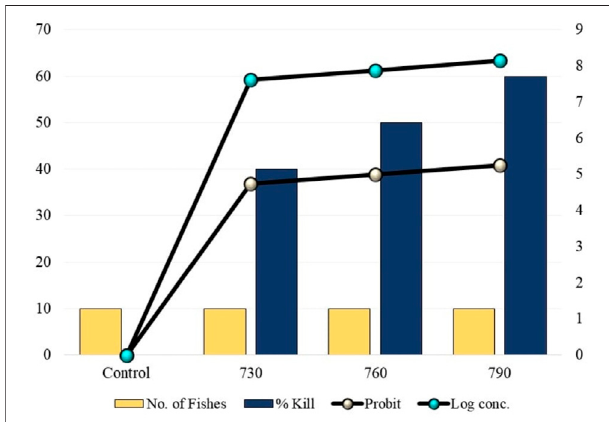
FIGURE 1 | 96 h mortality rates of fi shes at different concentrations of dichloromethane